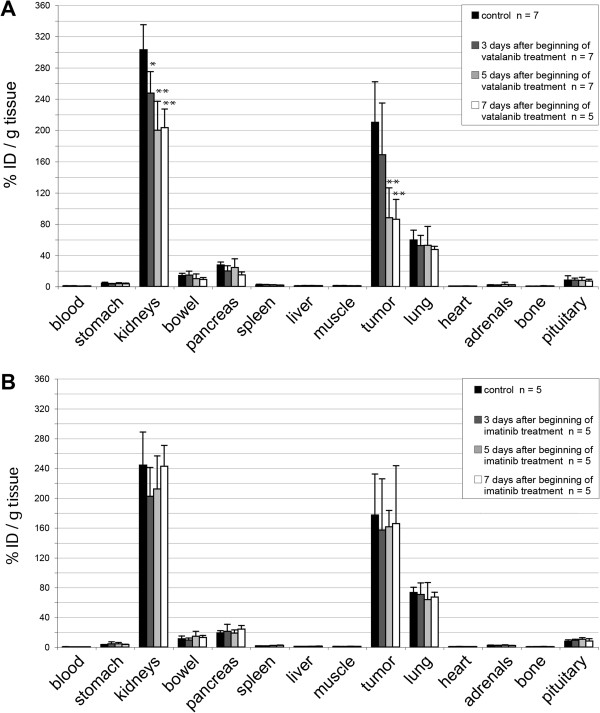
Biodistribution of [Lys40(Ahx-DTPA-111In)NH2]-exendin-4. (A) Treatment of Rip1Tag2 mice with the VEGFR2-inhibitor vatalanib induces a sharp decrease of [Lys40(Ahx-DTPA-111In)NH2]-exendin-4 uptake into the tumor tissue and kidneys. In particular, specific tumor uptake diminishes by more than 50% within the first 5 days of vatalanib treatment (**p < 0.01, *p < 0.05, Newman-Keuls post-test). (B) Pre-treatment of Rip1Tag2 mice with imatinib does not significantly affect the specific uptake of [Lys40(Ahx-DTPA-111In)NH2]-exendin-4 into the tumor tissue and organs.